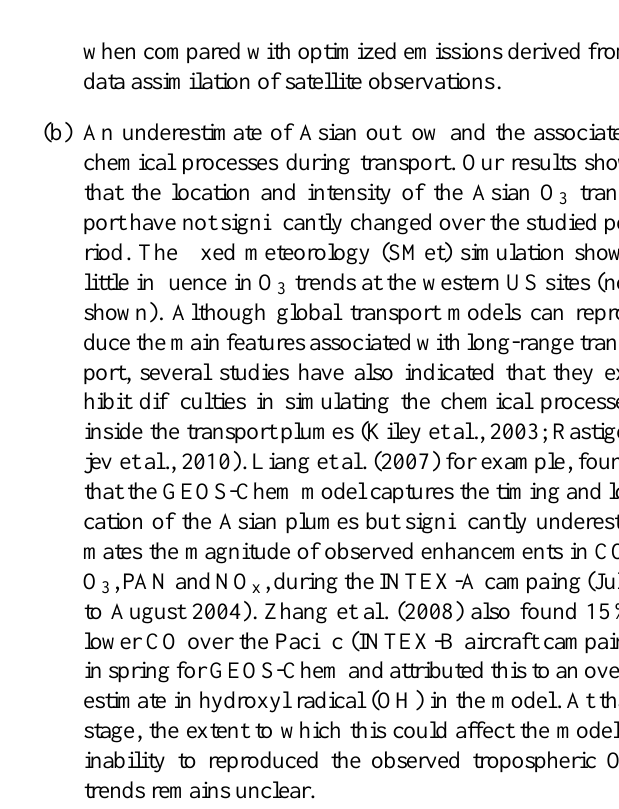
Fig. 7. Trends (%yr − 1 ) in the summertime CO concentrations at 52 stations from the WDCGG network for the observations (left) and the model (right) for the period 1991–2005. Circles and squares denote trends at sites above and below 1500m, respectively. Large symbols denote significant trends at the 0.05 level. Small symbols denote trends that are not statistically significant.